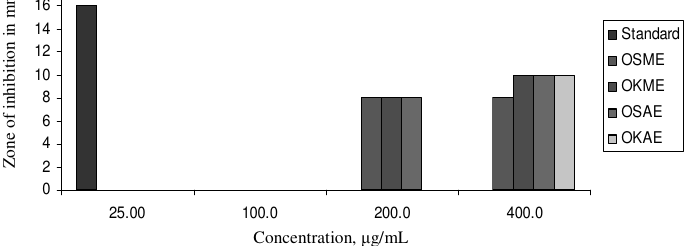
Figure 2. Antimicrobial activity of Ocimum extracts against B.subtilis